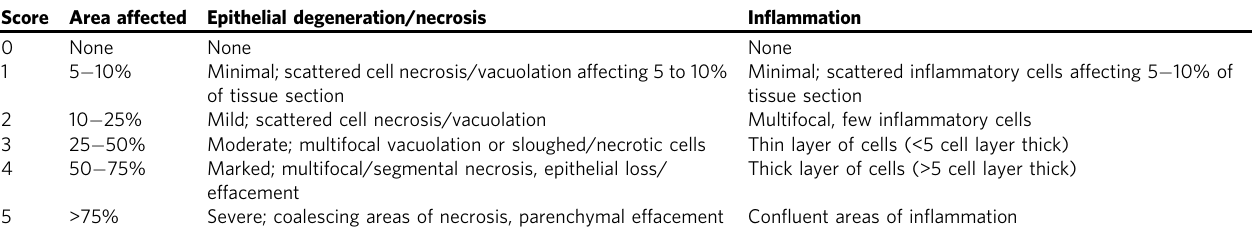
Table 1 Scoring system used to de fi ne the pathological changes in the